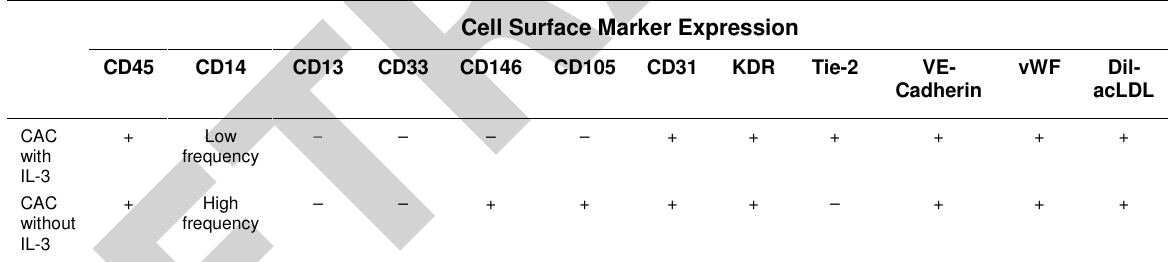
Characterization of Circulating and BM-Derived Angiogenic Cells Expanded in Response to IL-3 Cell Surface Marker